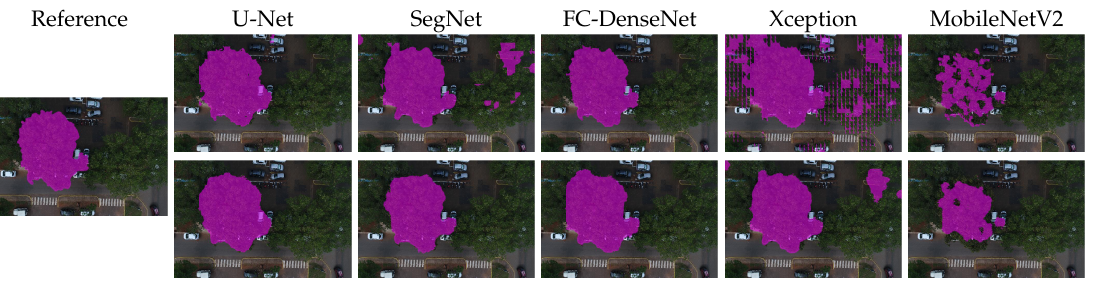
Figure 14. Sample Segmentation 5 prior (first row) and after CRF post-processing (second